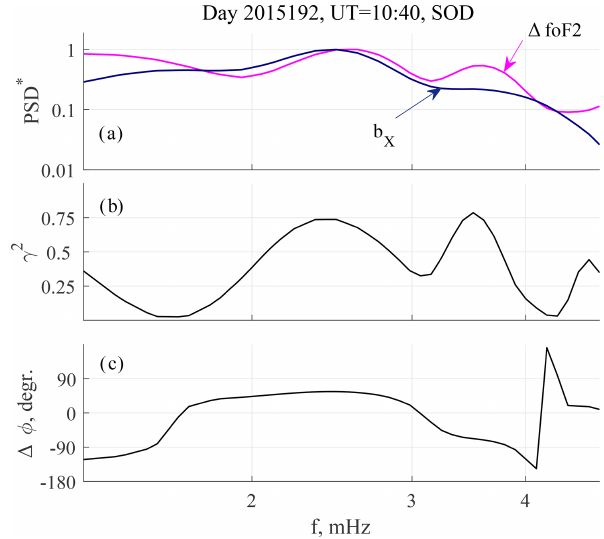
Figure 7. Spectral parameters for event 2: (a) normalized PSD spec- tra of (cid:49) fo F2 and b X pulsations; (b) spectral coherence; and (c) phase